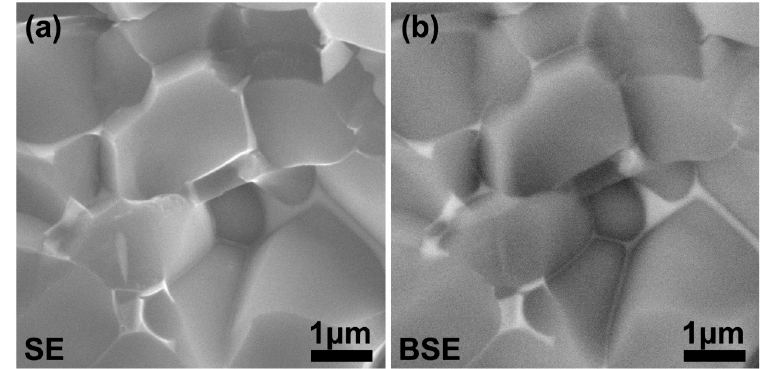
Figure 5. ( a ) SEM SE image and ( b ) the corresponding BSE image of the fracture surface of TiB 2 -5 wt. % CoCrFeNiAl composites sintered at 1650 °C.